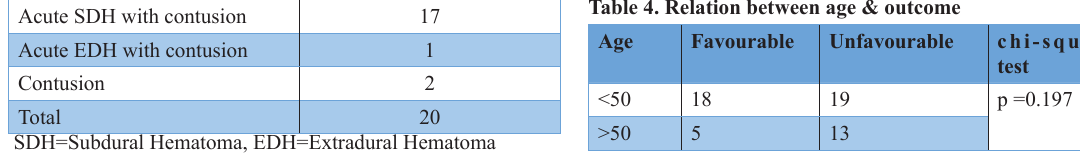
Table 1 . Imaging characteristics of the patients with trauma Imaging Diagnosis